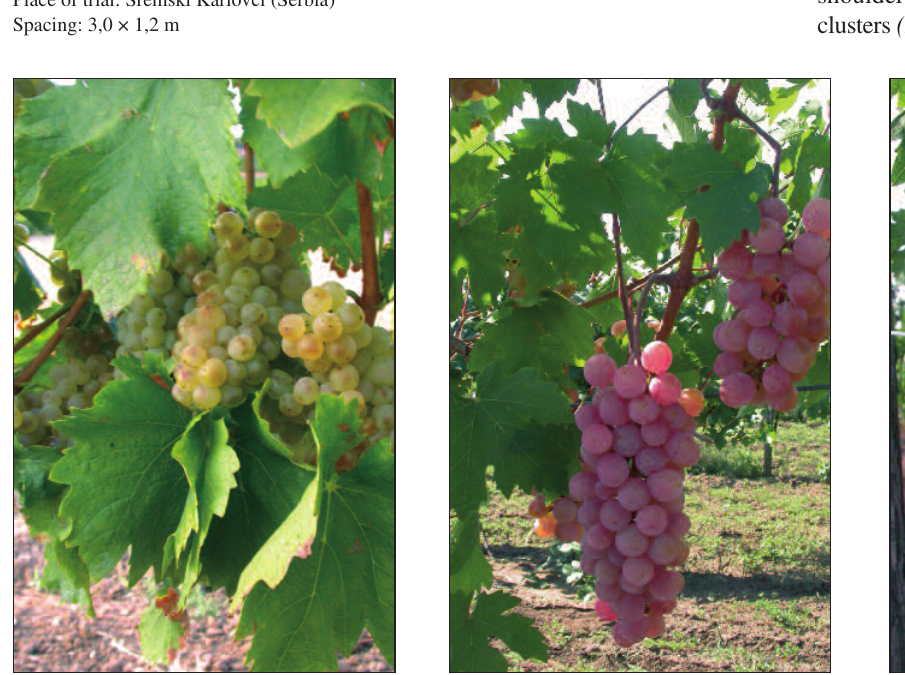
Fig. 10. Cegléd szépe K.73 Fig. 9. Welsch Riesling SK.54 Fig. 11. Pannónia kincse